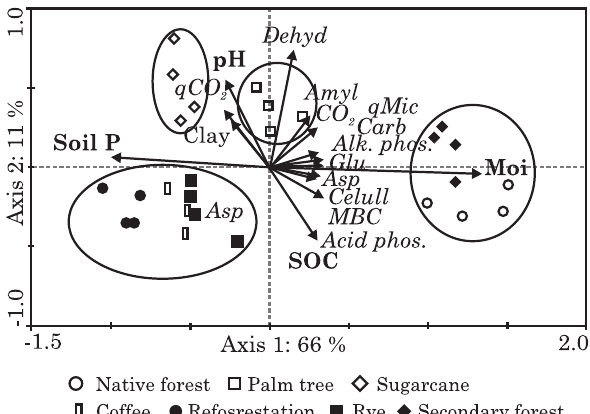
Figure 1. Principal component analysis (PCA) based on chemical, microbiological and biochemical properties in a clay soil under different types of management and plant cover. Environmental, explanatory variables in bold print: Moi (soil available P); SOC (soil organic carbon); Clay (water-dispersible clay). Microbiological/ Biochemical variables: MBC (microbial biomass quotient); CO 2 (basal respiration); Dehyd (dehydrogenase); Amyl (amylase); Glu (glutaminase); Alk. phos. (alkaline phosphatase); Acid phos. (acid phosphatase); Celull (cellulase); Asp (asparaginase); Carb (hot-water-soluble carbohydrates).